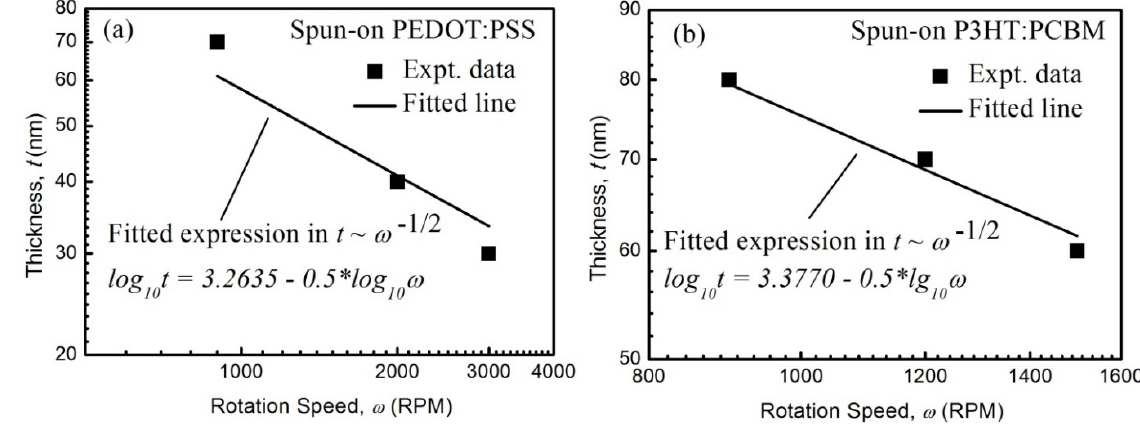
Figure 3. Measured spun-on film thickness by CLSM vs. rotation speed (solid square symbols) and fitting line based on the least squares method; ( a ) PEDOT: PSS film and ( b ) P3HT: PCBM film. The figure is in log-log scale. The R 2 in (a) is 0.9 and in (b) is